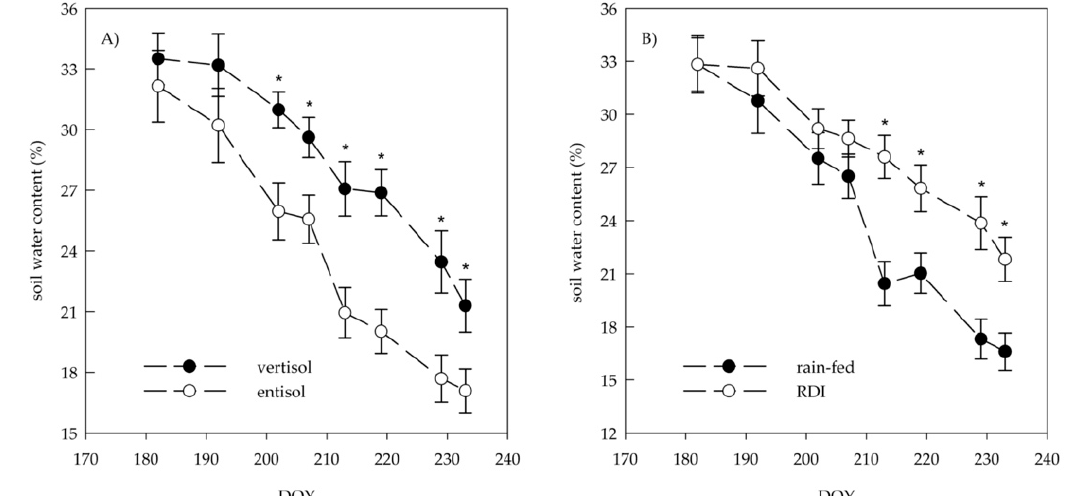
Figure 2. Variation of soil water content (%) over the season in two soils (vertisol and entisol) ( A ) and irrigation treatments (regulated deficit irrigation (RDI), and rain-fed) ( B ). Error bars indicate standard errors ( n = 24); DOY, day of the year. When present, asterisks indicate significant differences between means (Tukey’s test, p < 0.05).